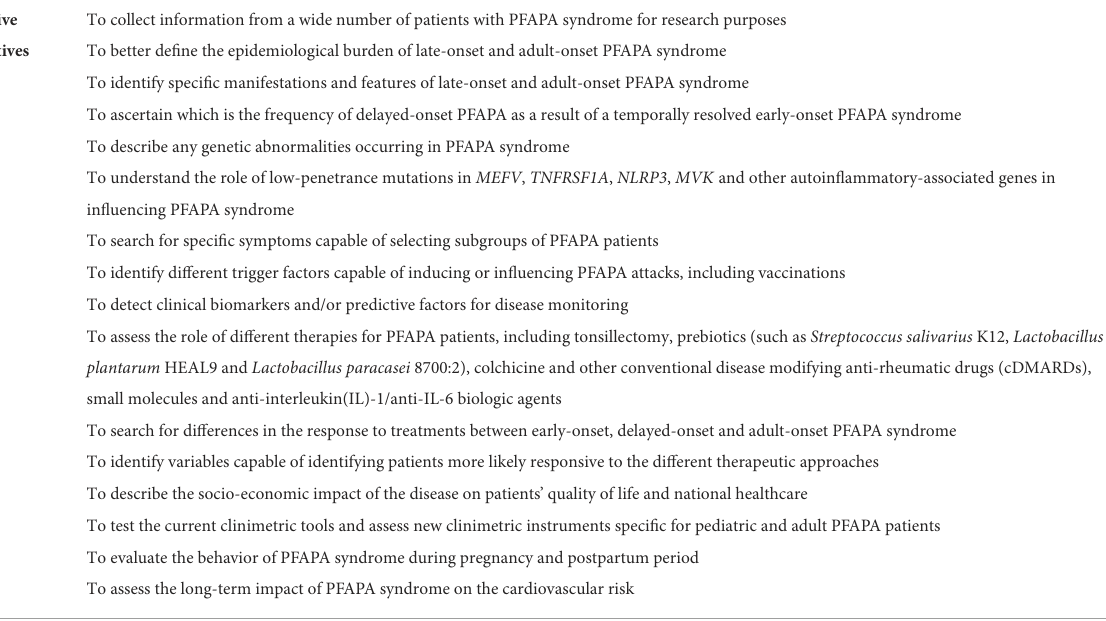
TABLE 1 List of objectives of the AIDA Registry dedicated to PFAPA